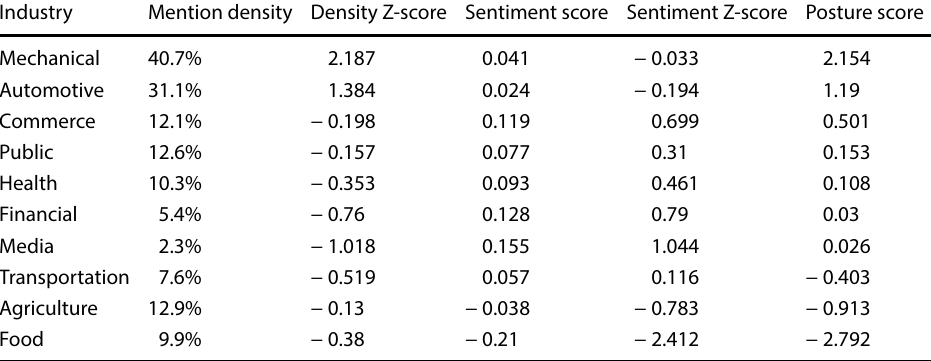
Table 1 Industry cybersecurity